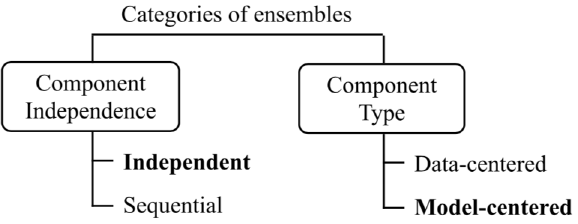
Figure 4. Categorization of ensemble